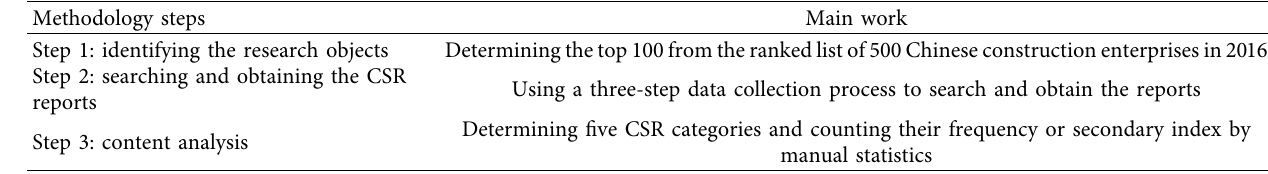
Table 1: Description of the research